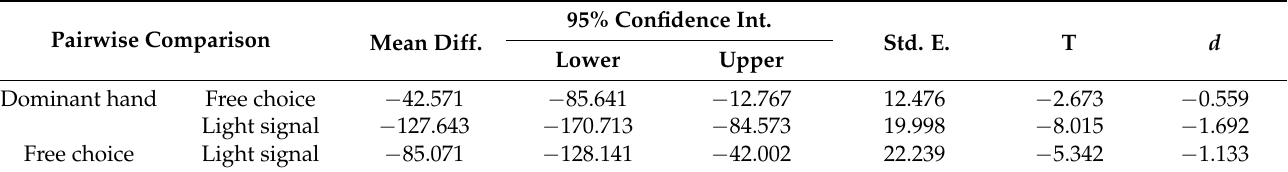
Table 2. Effect of decision process on single movement response time of the dominant arm.